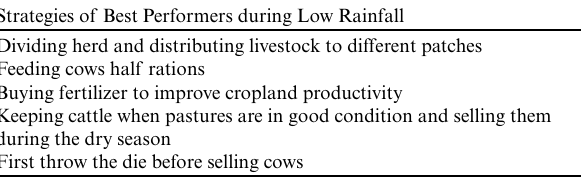
Table 2 . Strategies identified from observations of the best performers of the grazing game in